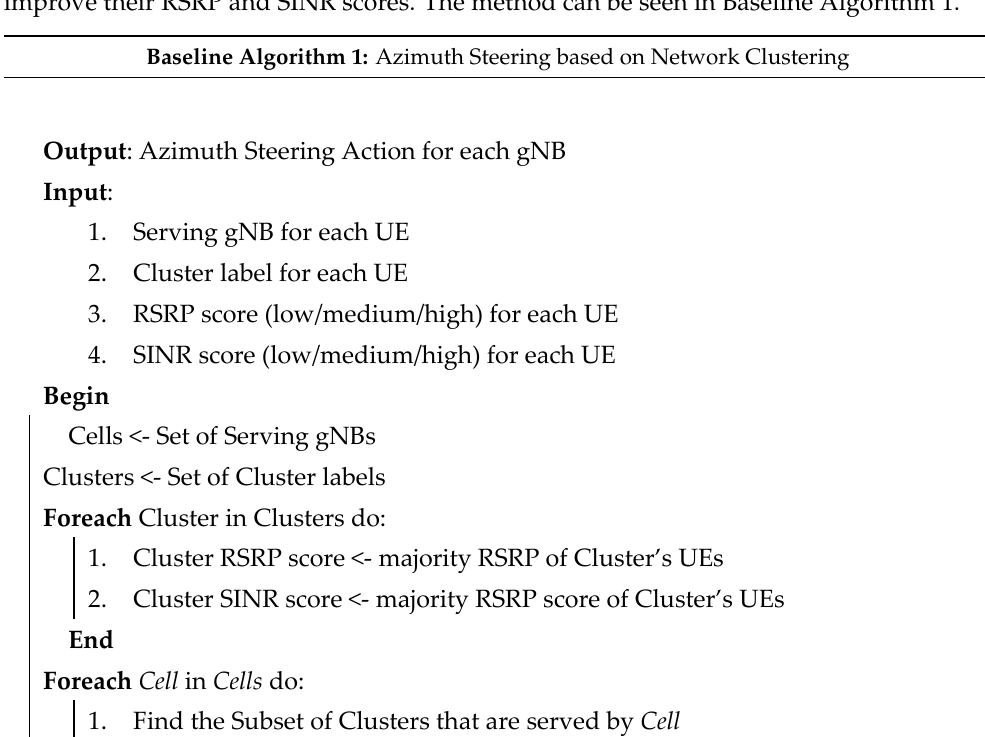
Baseline Algorithm 1: Azimuth Steering based on Network Clustering